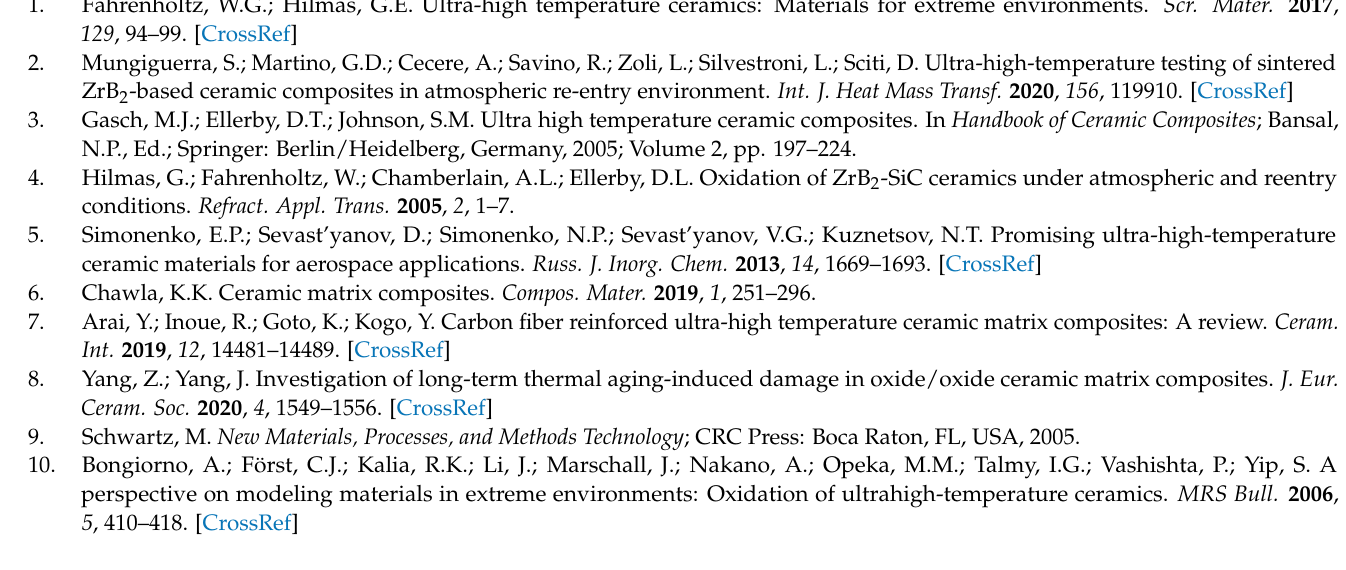
cross section: two halves of the coating cross section are compared (black area = resin), Figure S2: SEM image of the coating B2, ZrB 2 -SiC (50%-50%)—metallographic cross section: details, Figure S3: SEM image of the coating B2, ZrB 2 -SiC (50%-50%)—metallographic cross section: coating thickness, Figure S4: SEM image of the coating B2, ZrB 2 -SiC (50%-50%)—metallographic cross section: coating thickness, Figure S5: SEM image of the coating B2, ZrB 2 -SiC (50%-50%)—metallographic cross section: details, Figure S6: SEM-EDS analysis of the coating B2, ZrB 2 -SiC (50%-50%): area analysis, Figure S7: SEM-EDS analysis of the coating B2, ZrB 2 -SiC (50%-50%): point analysis, Figure S8: SEM image of the coating B1, ZrB 2 -SiC (70%-30%)—metallographic cross section: two halves of the coating cross section are compared (black area = resin), Figure S9: SEM image of the coating B1, ZrB 2 -SiC (70%-30%)—metallographic cross section: details, Figure S10: SEM image of the coating B1, ZrB 2 -SiC (70%-30%)—metallographic cross section: coating thickness, Figure S11: SEM image of the coating B1, ZrB 2 -SiC (70%-30%)—metallographic cross section: coating thickness, Figure S12: SEM image of the coating B1, ZrB 2 -SiC (70%-30%)—metallographic cross section: details, Figure S13: SEM image of the coating B1, ZrB 2 -SiC (70%-30%)—metallographic cross section: details, Figure S14: SEM-EDS analysis of the coating B1, ZrB 2 -SiC (70%-30%): area analysis, Figure